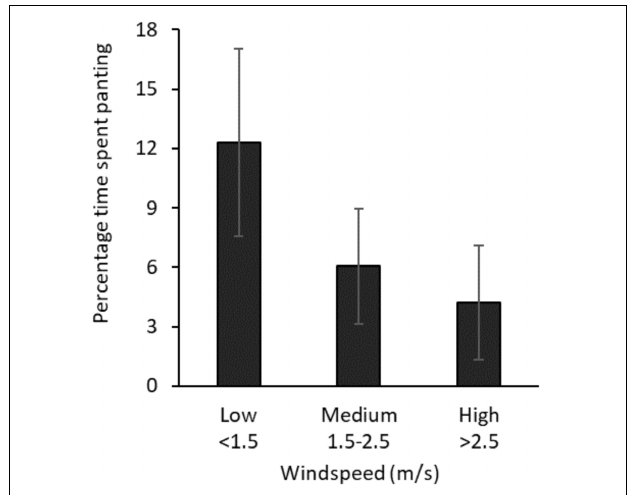
FIGURE 4 | Mean percentage of time birds spent panting at air temperatures > 35 ◦ C, by windspeed (m/s). Error bars show